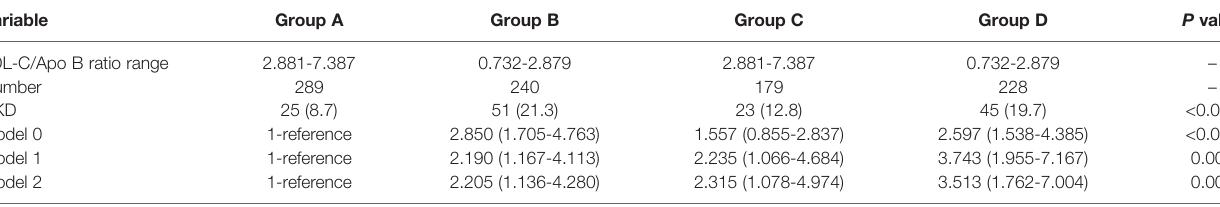
TABLE 4 | ORs (95% CIs) of DKD according to the four